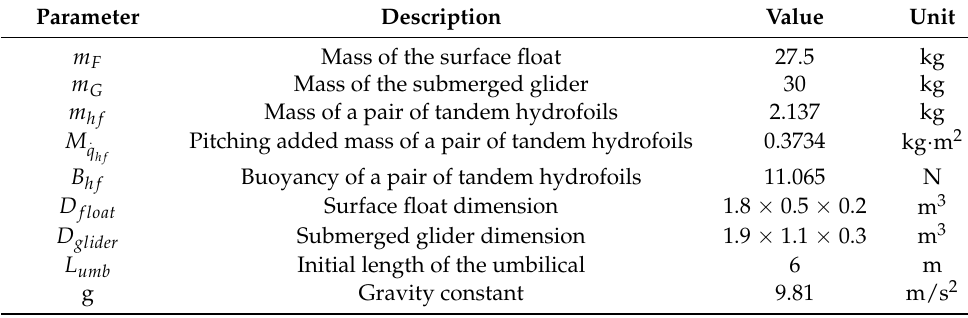
Table 3. Non-dynamic parameters of the “Black Pearl” wave glider.